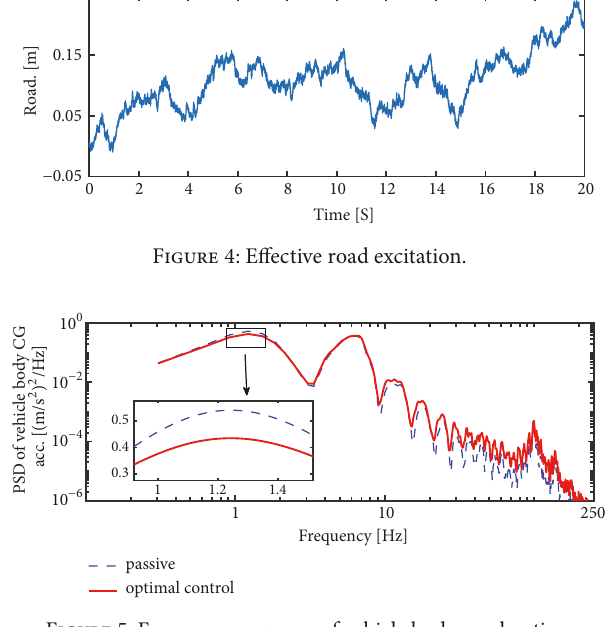
Figure 5: Frequency response of vehicle body